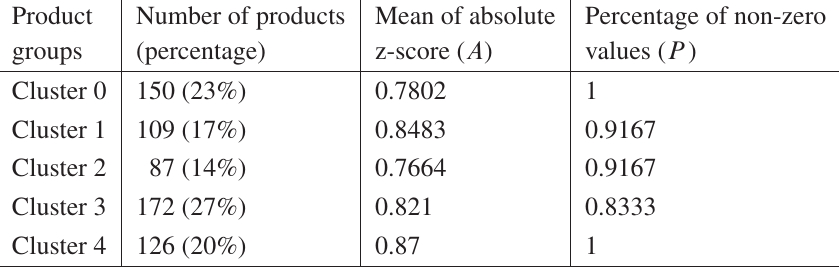
Table 12. Tier-2 monthly stability analysis with the K -Means algorithm in